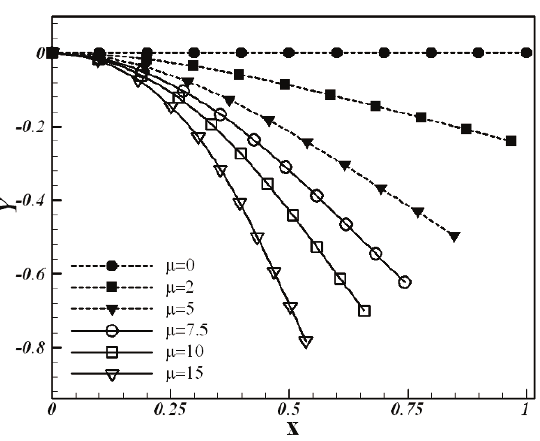
Fig.5. Effects of dimensionless weight parameter μ on position. Figure 5. Effects of dimensionless weight parameter µon position.